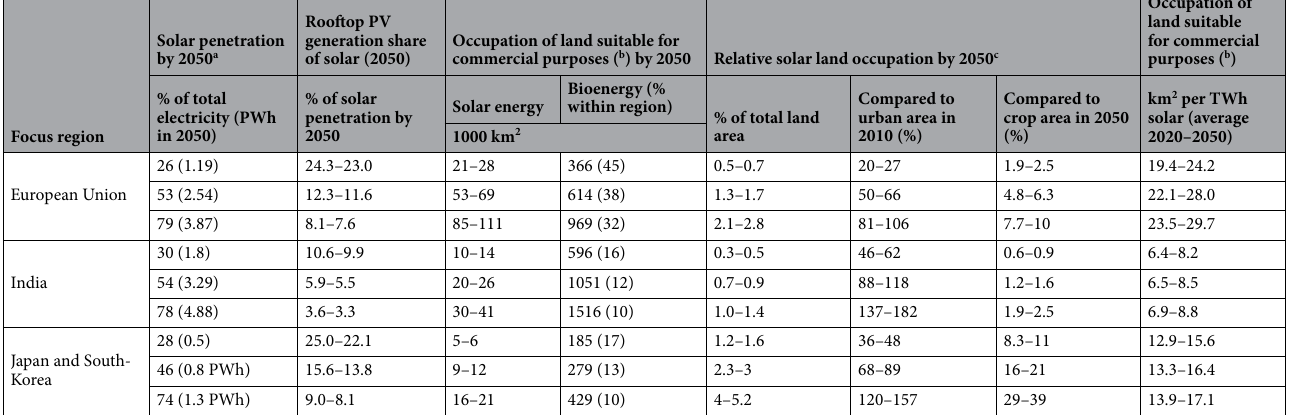
Table 1. Land occupation characteristics at different solar penetration levels by 2050. Ranges show results for with different future solar module efficiencies with left values within each solar-related column representing 28% efficiency and right values 20%. Results for bioenergy scenarios included for comparison. a These are realized penetration levels. See Section 1b in the SM for more information. b Land suitable for commercial